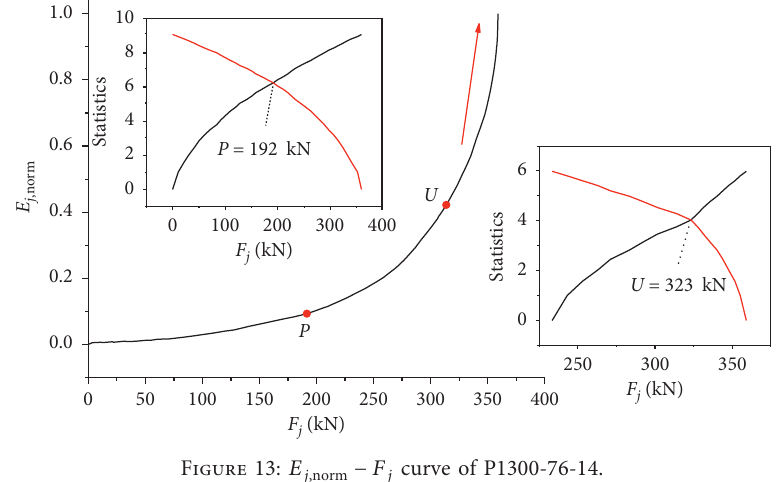
Figure 13: E − F j, norm j curve of P1300-76-14. Table 6: Comparison of experimental data and simulated data.